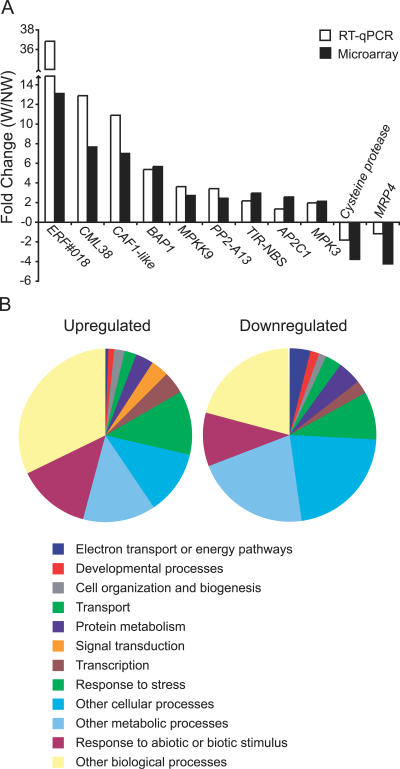
Verification and Functional Classification of the RWR Genes(A) RT-qPCR expression analysis of selected genes normalized to the 60S ribosomal protein L14 (At4g27090) measured in the same samples. The resulting relative expression was then used to calculate fold change upon wounding. Data are means of n = 3.(B) Functional classification of RWR genes using GO annotations.